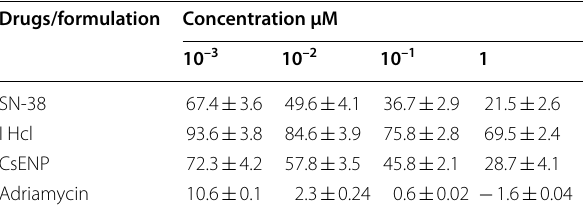
Table 7 Percent growth inhibition at different concentrations of SN-38, IHCl, drug loaded nanoparticles at various concentrations for HT-29 cell line